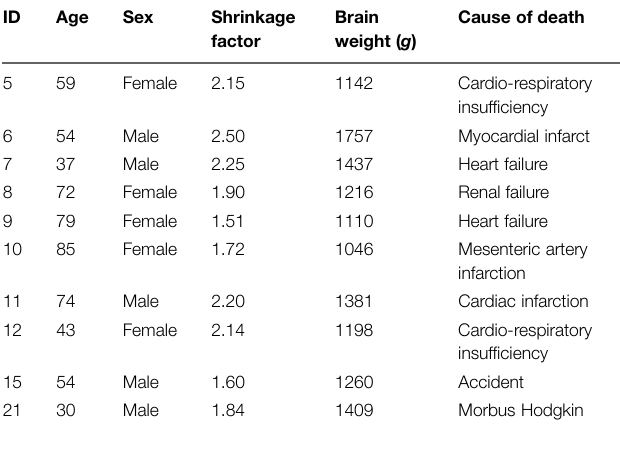
TABLE 1 | Sample of post mortem brains used for cytoarchitectonic